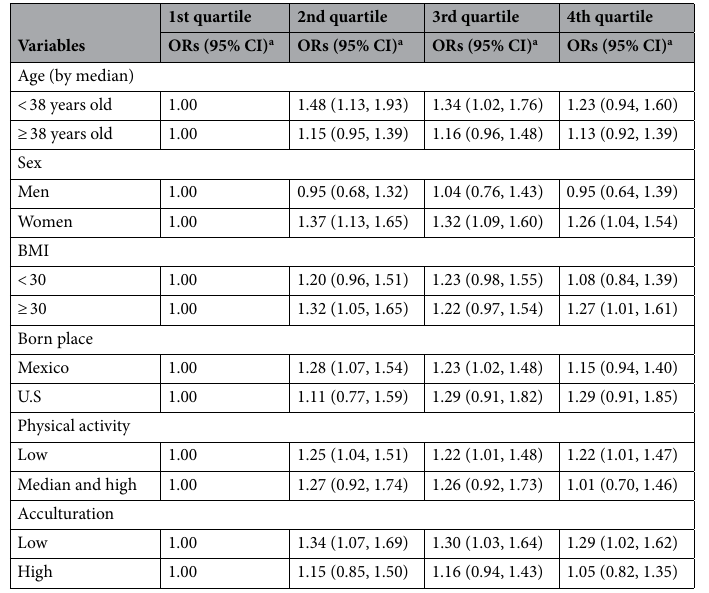
Table 5. Association between rundle’s LUM and telomere length stratified by demographic variables. a Adjusted by age, sex, BMI, physical activity, health insurance, born place, acculturation, and census income as